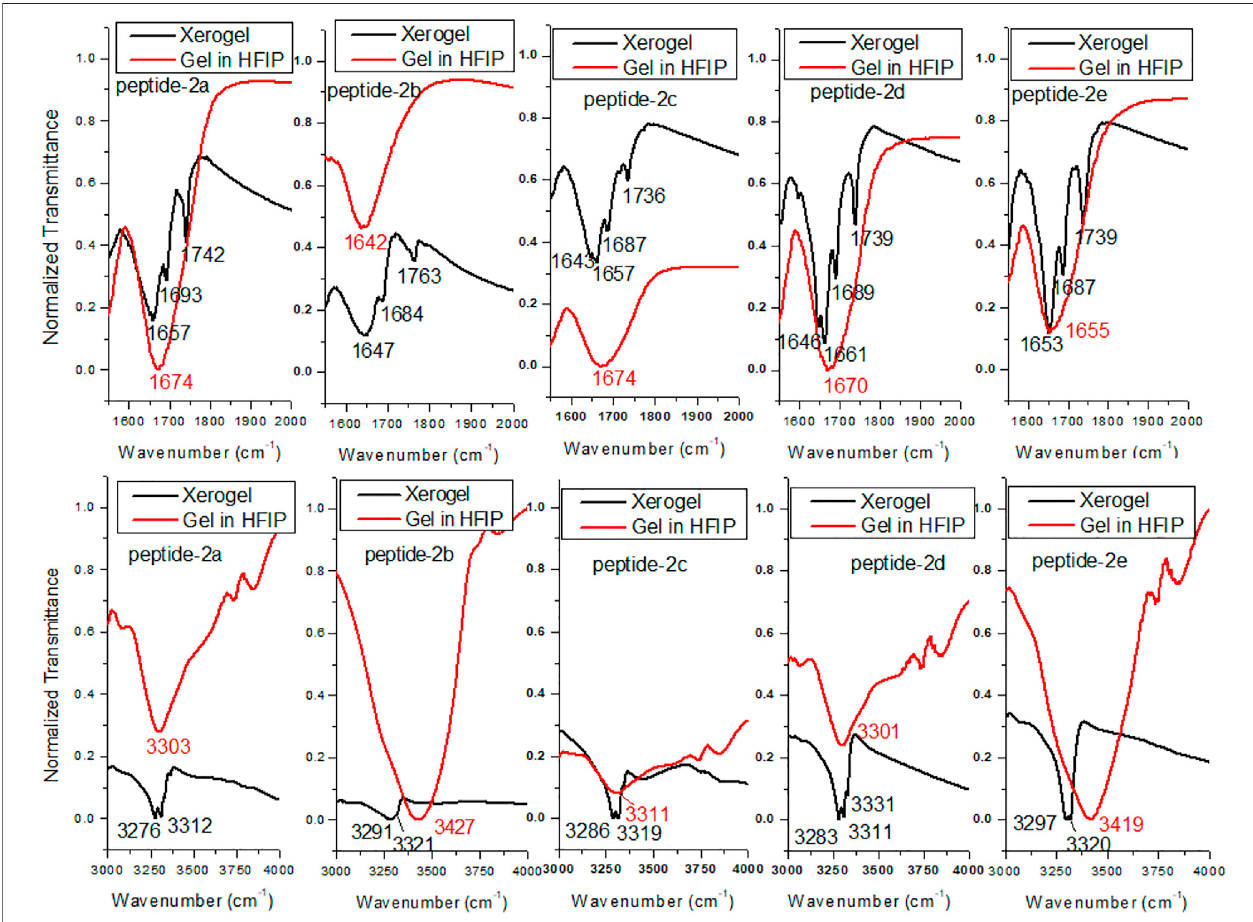
FIGURE 6 | FT-IR of APA-peptide 2a - 2e xerogels and gels dissolved in HFIP. Carbonyl region (top) and amide NH region (bottom).